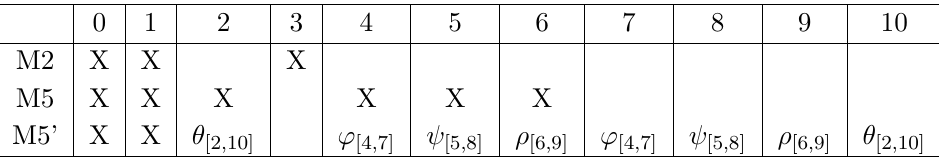
Table 2 . M-theory brane